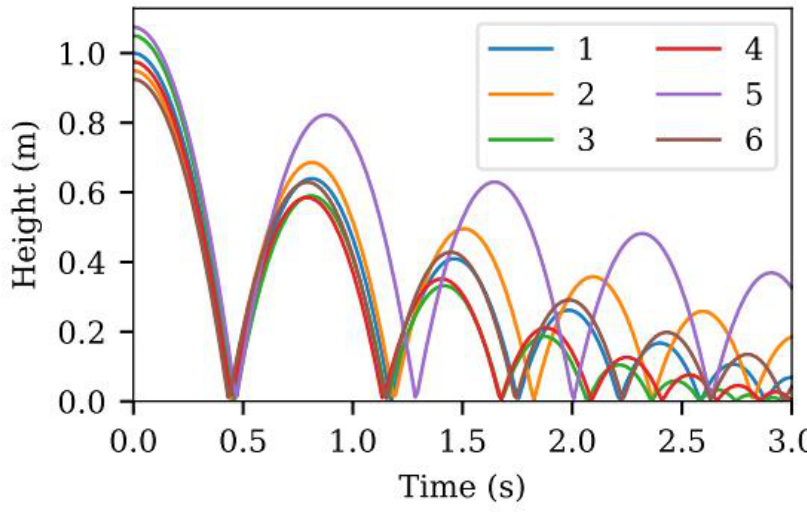
Figure 4. The first 6 trajectories of the training set with both the coefficient of restitution and initial height